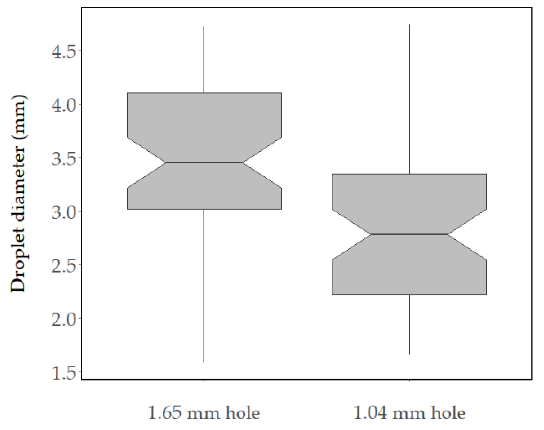
Figure 1. The diameter of sampled drop populations, inferred by volume, based on the size (1.65 or 1.04 mm) of the holes in the rose head. Boxes represent the interquartile range, with the middle horizontal line indicating the median, and whiskers represent the minimum and maximum values. Table 1. Total particle, cell, and environmental data from simulated rain events. The total particles and cells scavenged (0.2 to 2 µm in diameter) are average concentrations ± standard error of the mean, n = 3. (EDT: Eastern Daylight Time).